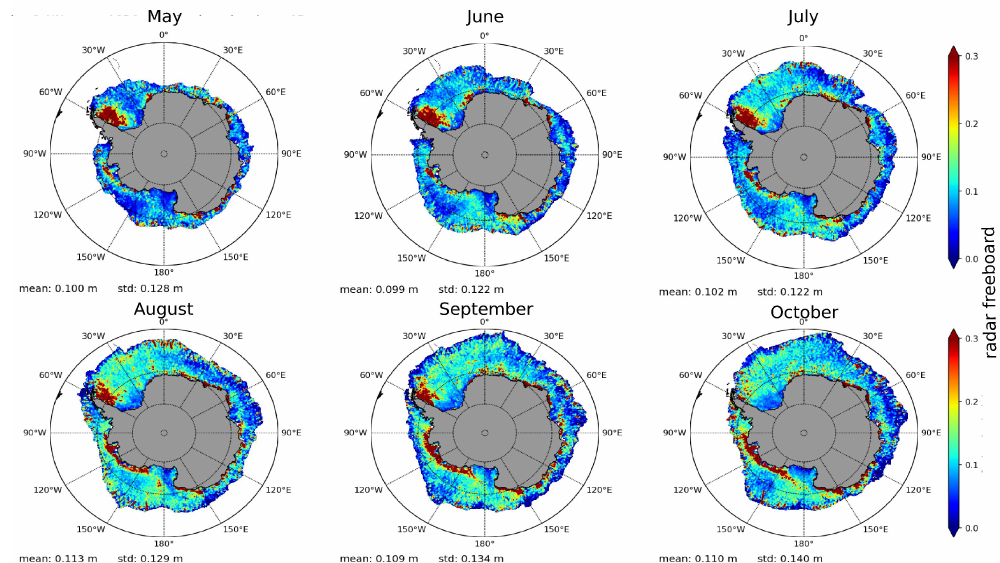
Figure A2. Monthly mean maps of the calibrated Envisat radar freeboards in winter 2011.